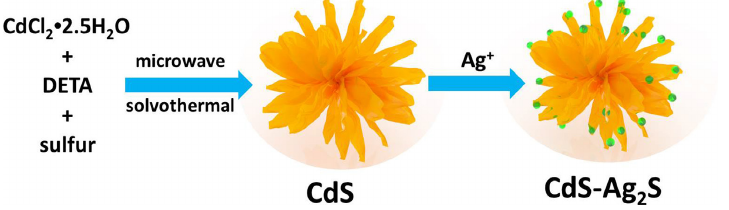
Figure 14. Schematic illustration of synthesis procedure for hierarchically structured CdS–Ag 2 S nanocomposites. Copyrights 2019 Elsevier